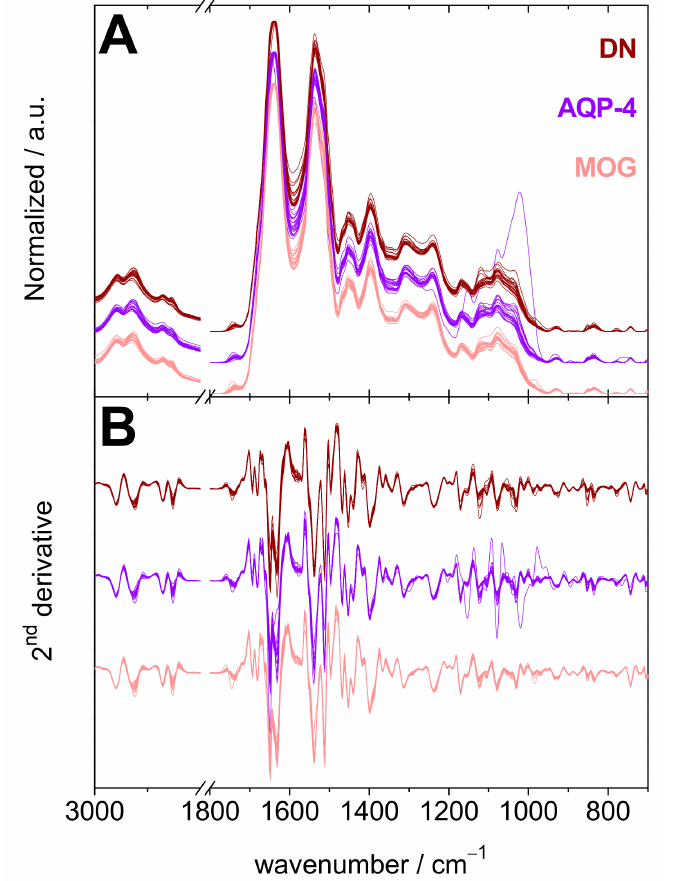
Figure 3. Infrared data of NMOSD sera samples. ( A ) Normalized FTIR spectra of the sera samples of all NMOSD patients in the 3000–2800 and 1800–700 cm − 1 spectral ranges. ( B ) Second derivatives of the spectra of panel A. Double negative (DN) (dark red), AQP-4-Ab-positive (AQP-4) (violet), and Myelin oligodendrocyte glycoprotein-Ab-positive (MOG) (light red). The groups of spectra and derivatives are off-set for